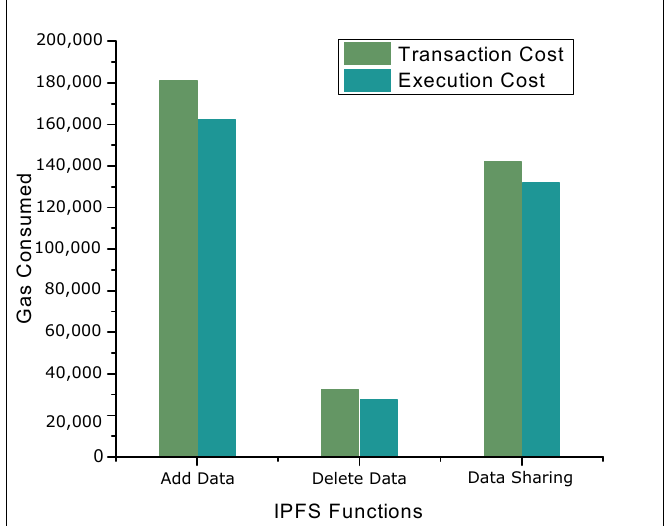
Figure 4. Gas Consumption for IPFS Functions.